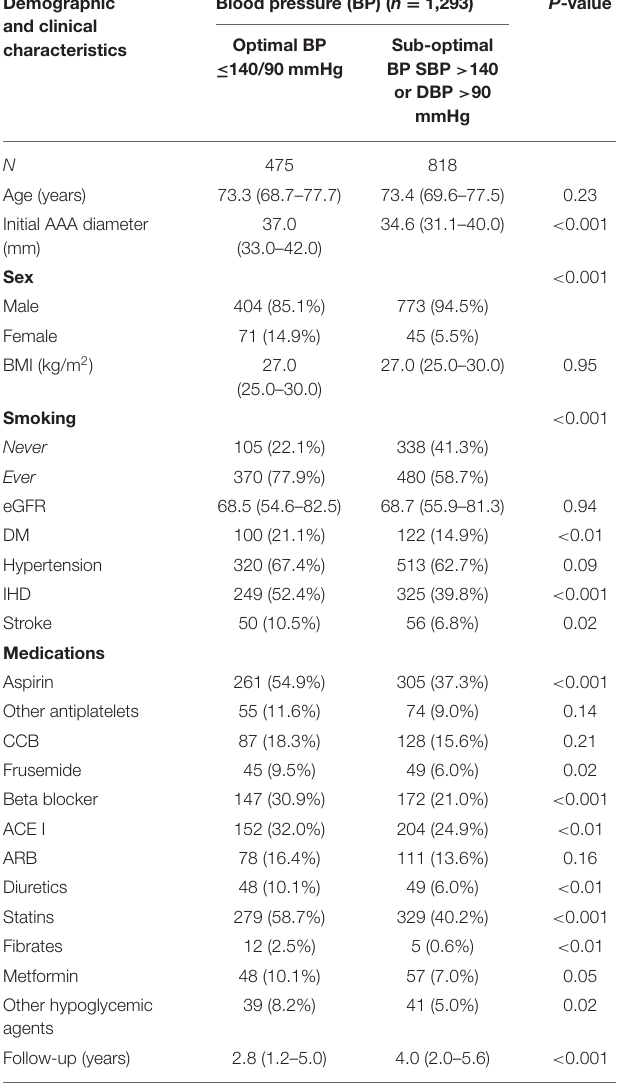
TABLE 1 | Characteristics of the participants in relation to whether they had optimal or sub-optimal blood pressure control. Demographic and clinical